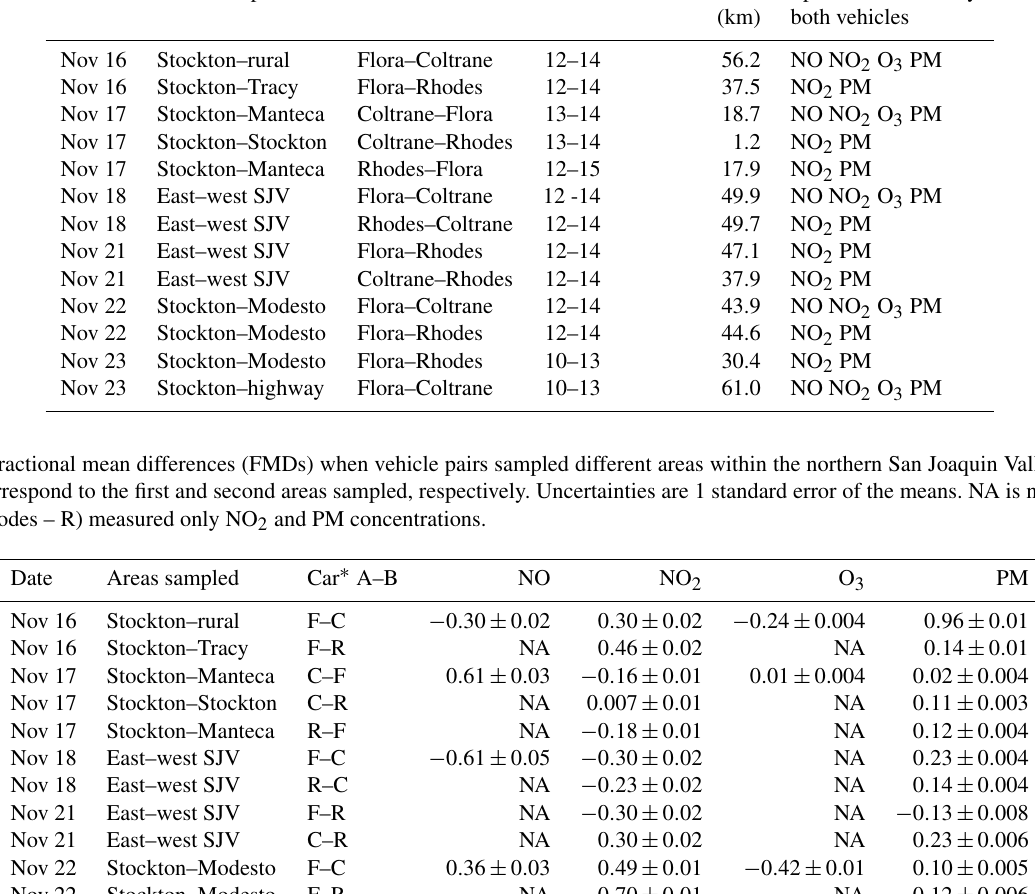
Table 11. Dates, locations, and times when vehicle pairs sampled different areas within the northern San Joaquin Valley. Areas sampled